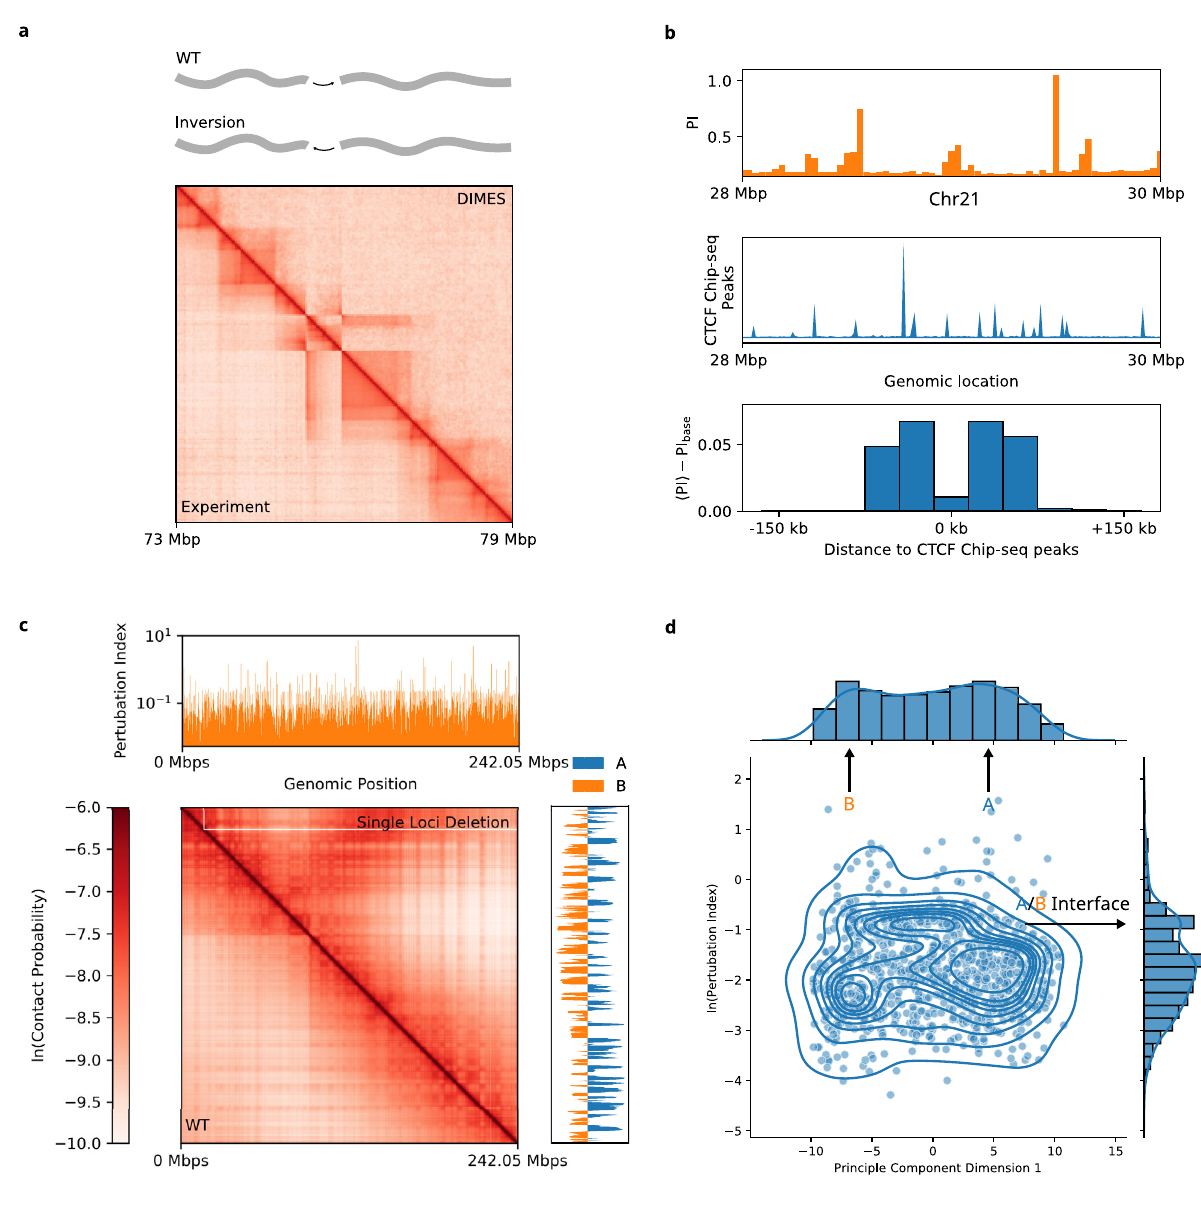
Fig. 8 | Predictions for structural variants. a Experimentally measured Hi-C contactmapforthe1.1-MbhomozygousinversionforChr1fromthemousecell lineE11.5(lowertriangle).Thepositionofthesegment thatisinvertedisshown on the track in the top panel. The predicted contact map using DIMES with the perturbation on the WT Hi-C data (see main text and Supplementary Note 3) is shownforcomparison(uppertriangle). b Top:PerturbationIndex(PI)forChr21 28 – 30 Mbp. Middle: Chip-seq data for CTCF. Bottom: average value of PI as a function of genomic distance from CTCF Chip-seq peaks. Average PI values up